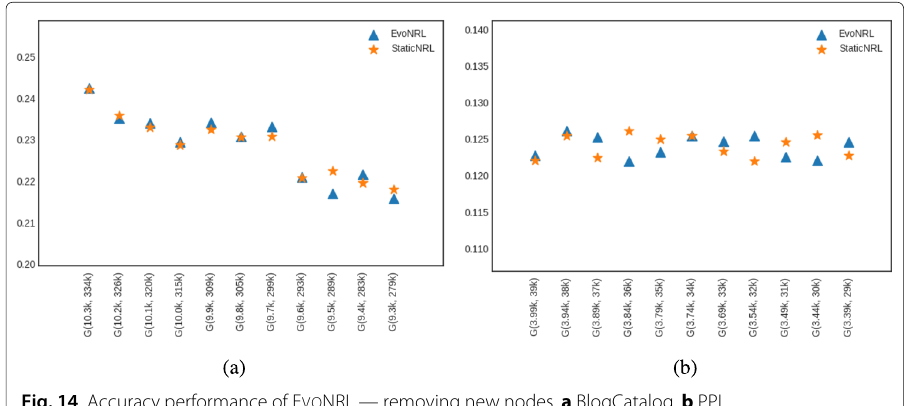
Fig. 14 Accuracy performance of E VO NRL — removing new nodes. a BlogCatalog, b